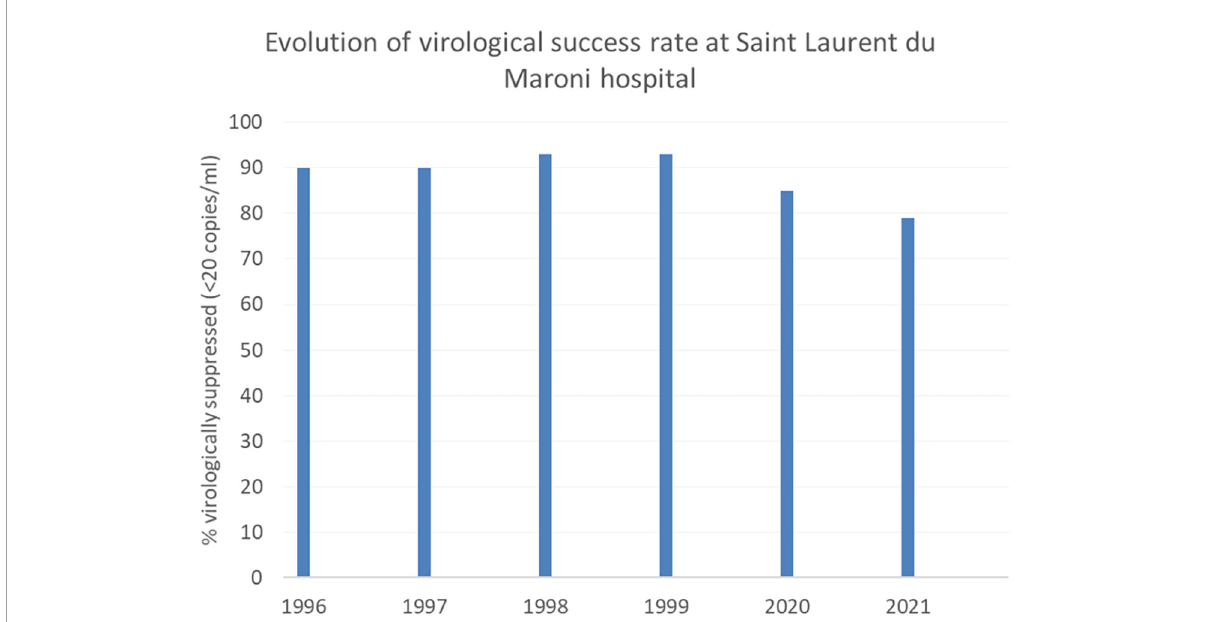
FIGURE2 In 2020 and 2021, in Saint Laurent du Maroni HIV outpatient clinic, the proportion of virologically supressed patients dropped following COVID-19-related disruption of health services and border closure.